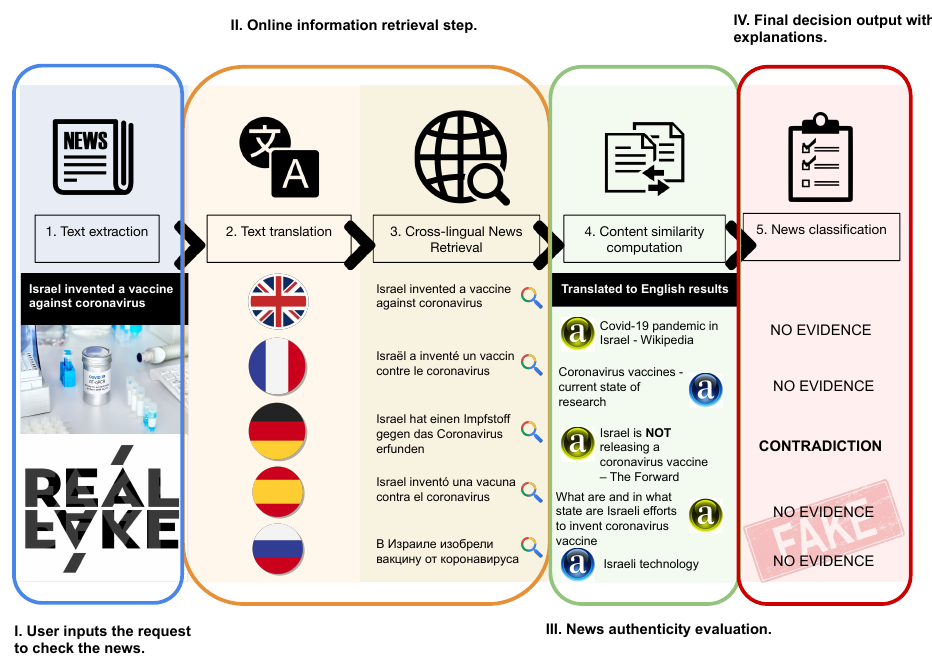
Figure 2. Overview of our approach: checking for fake news based on cross-lingual evidence